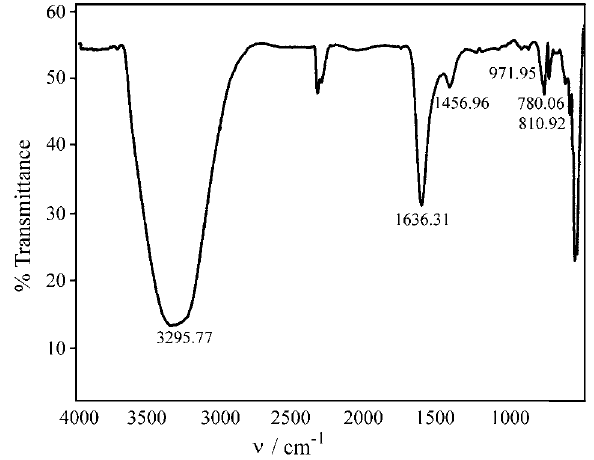
Figura 5c. Espectro IR característico de una disolución de 0.2 M de SnCl 2 , correspondiente a la muestra líquida obtenida del filtrado del sistema SnCl 2 -NH 4 OH-H 2 O a pH